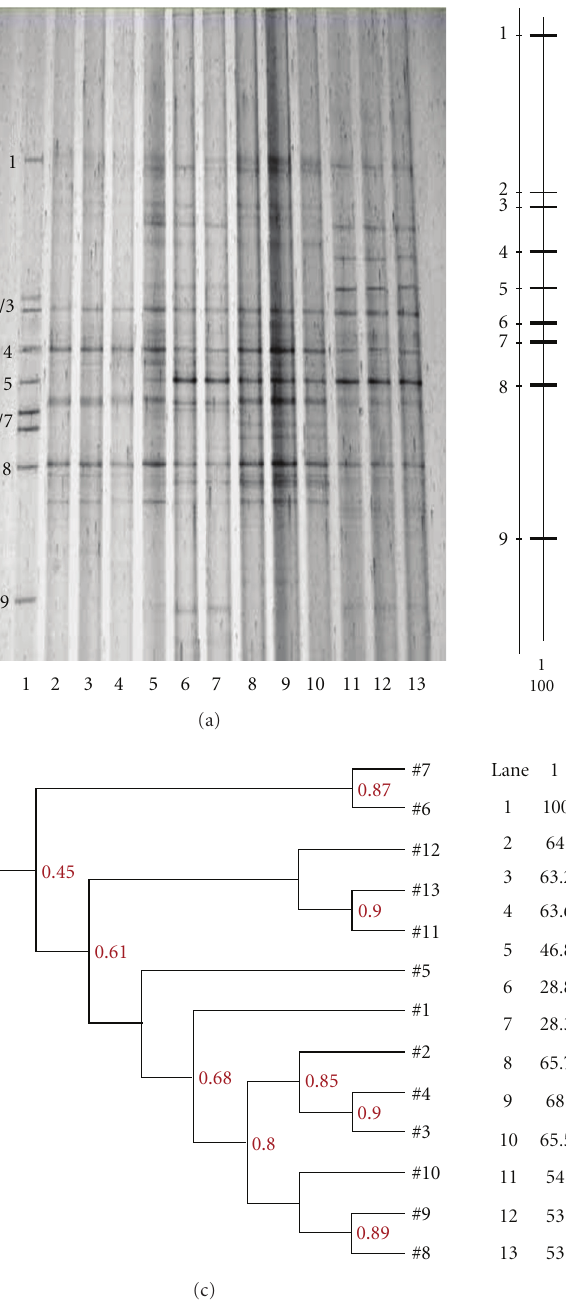
Figure 4: (a) DGGE profiles of V 3 amplicons in cecal microbiota of rats fed diets supplemented with 0 (2 to 4), 0.25 (5 to 7), 0.5 (8 to 10), and 1.0 (11 to 13) g/kg CYP 3 on day 21 after the initiation of supplementation. The standard strains (1) listed in order from the top of the gel to the bottom were Staphylococcus aureus , Lactobacillus amylovorus , Lactobacillus salivarius , Ruminococcus forques , Bacillus subtilis , E. coli O157:H7, Clostridium perfringens , Salmonella typhimurium , and Clostridium lituseburense , respectively. (b) Sketch map of the DGGE profiles. (c) and (d) Similarity indices of the DGGE